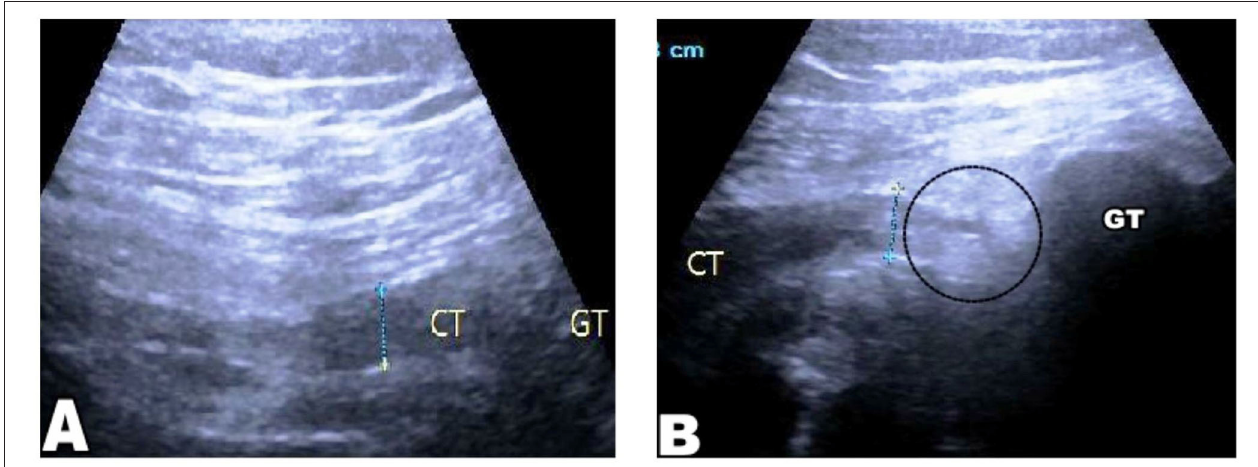
FIGURE 4 | Musculoskeletal ultrasound examination, (A) “CT” indicates the preoperative conjoint tendon morphology; “GT” indicates the greater trochanter of the femur; (B) “CT” indicates the conjoint tendon morphology after lysis; the continuity of the tendon is interrupted, slightly tortuous, and has poor tension. The black circle indicates the position of the interrupted conjoint